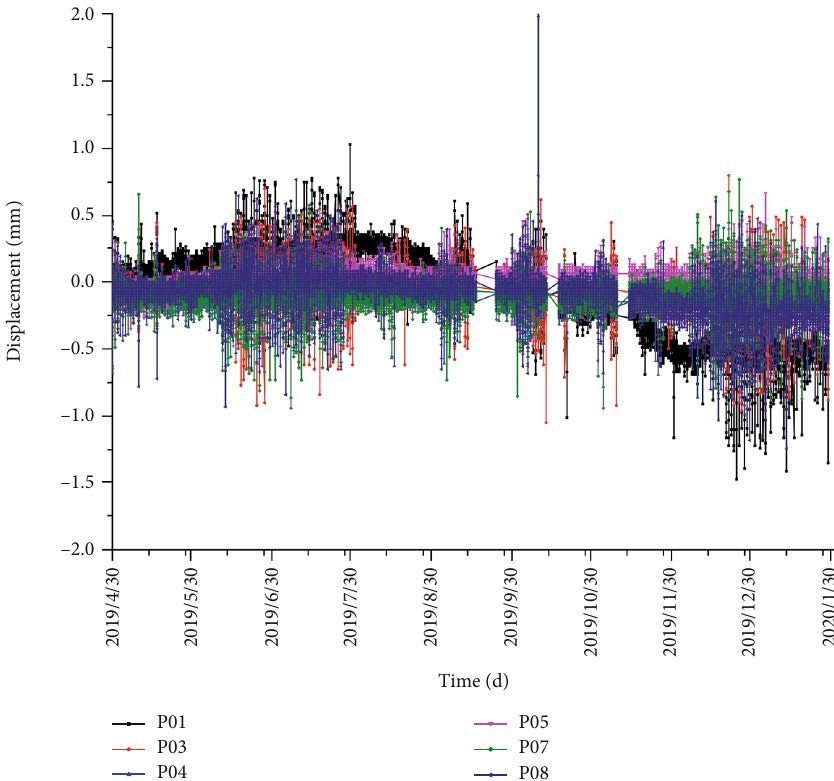
Figure 7: Rock fi ssure displacement monitoring